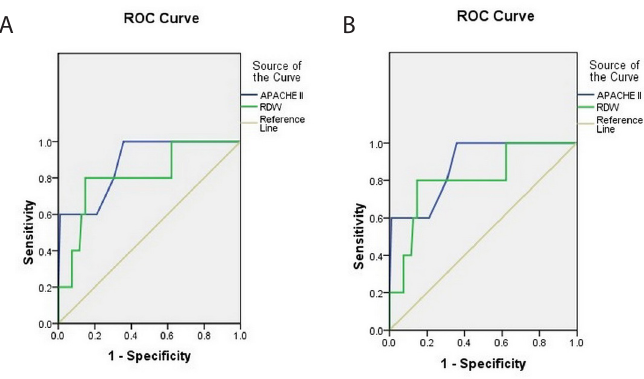
Figure 2. ROC for patients’ RDW and APACHE II score based on predicting (A) admission complications and (B) mortality in patients